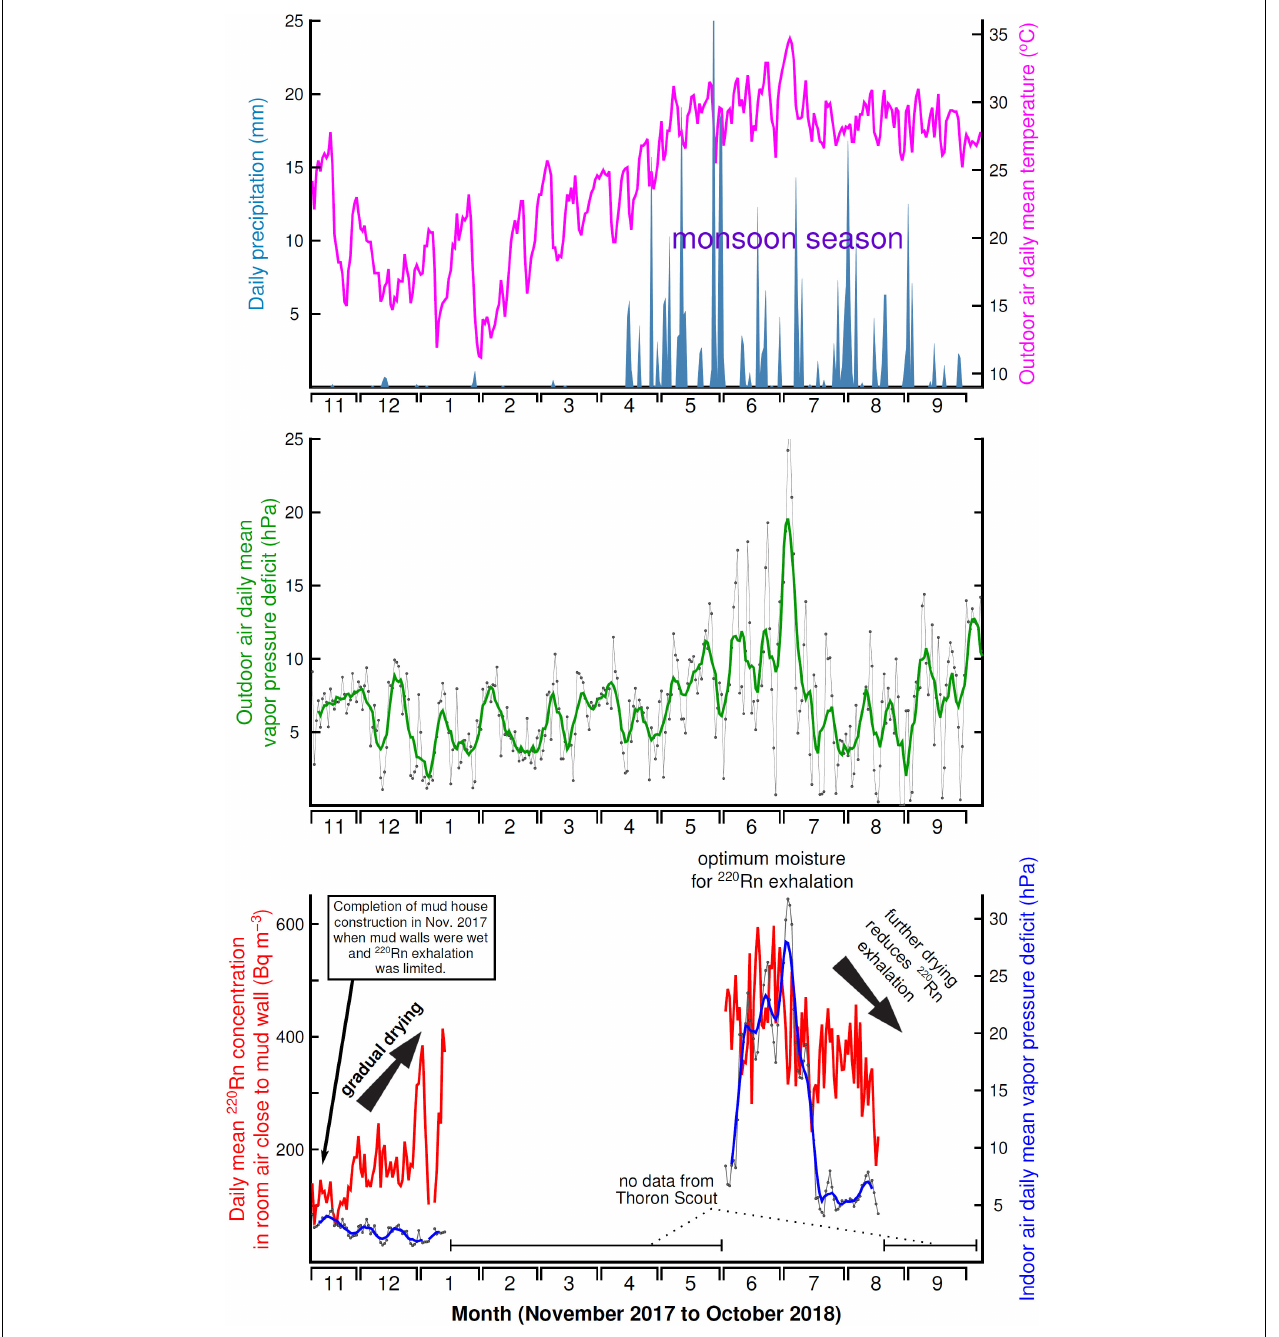
FIGURE 6 | Time-series of daily averages of 220 Rn concentration in room air of a mud house near Hà Nô.i based on measurements with a SARAD R (cid:13) Thoron Scout, in comparison with meteorological time-series of Hà Nô.i outdoor air (measured at Hà Nô.i–Nô.i Bài International Airport) and mud house indoor air (measured by Thoron